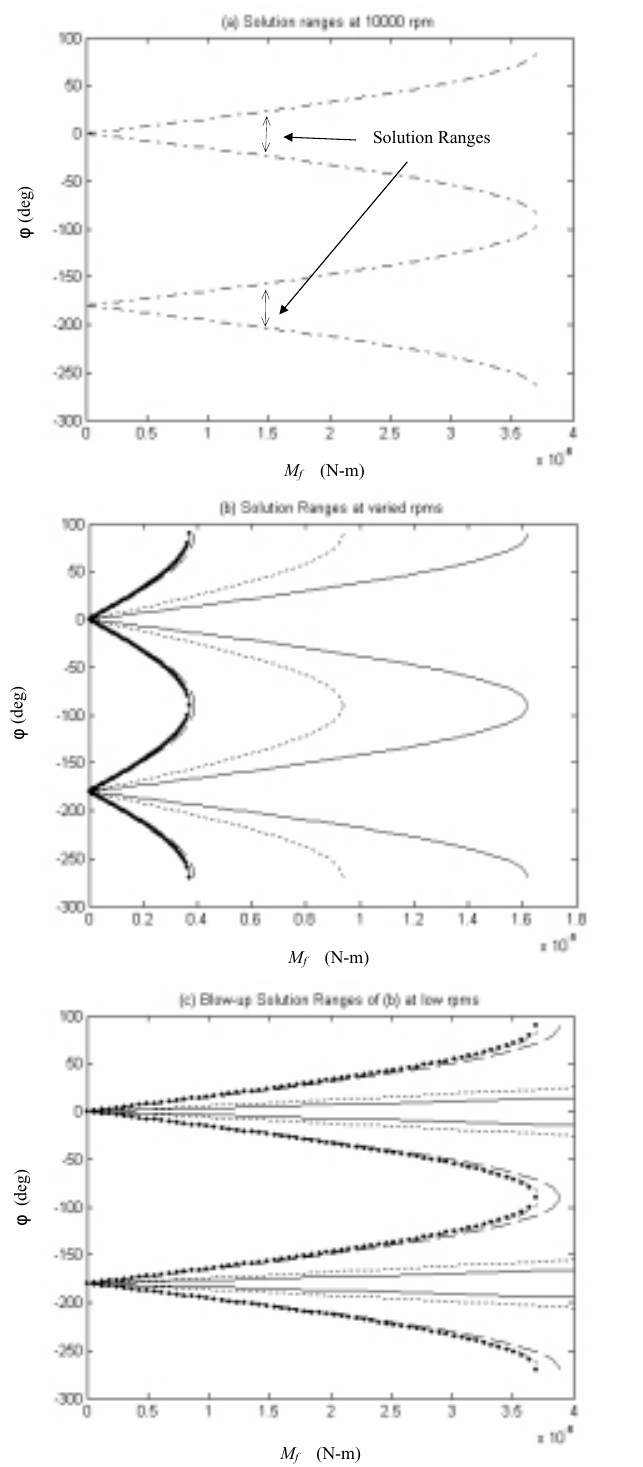
Fig. 4. The possible solution ranges of φ versus various rolling resistance M f